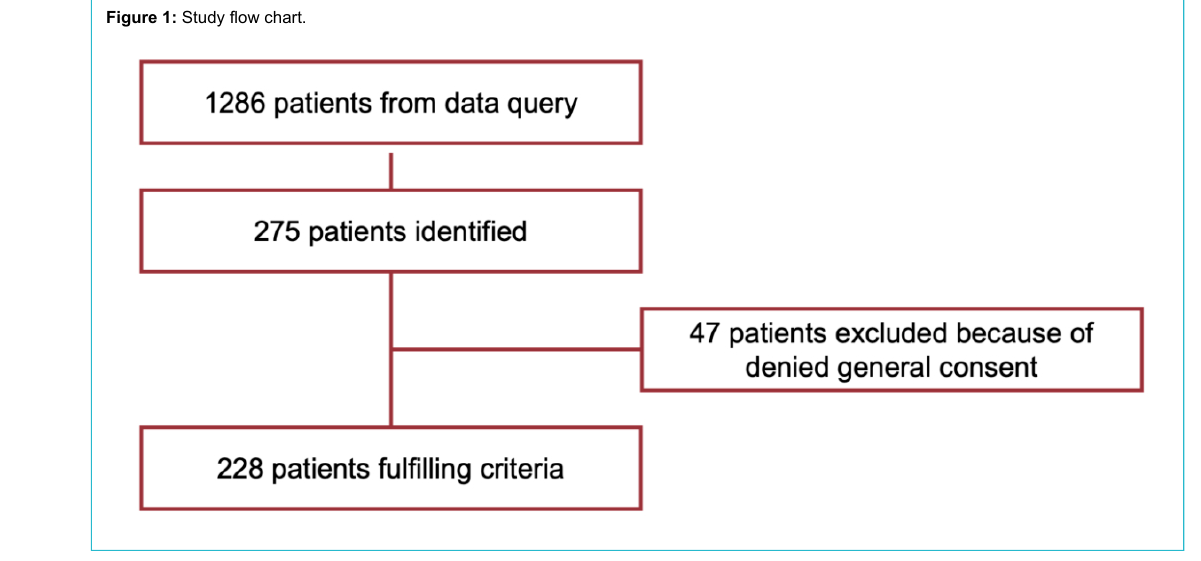
Figure 1: Study flow